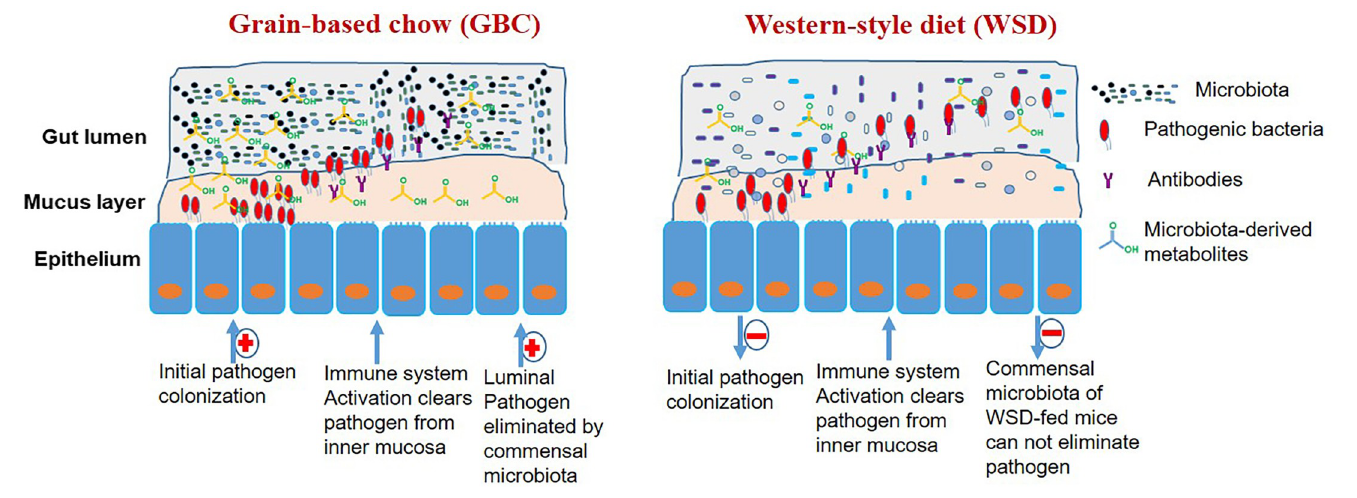
Fig 8. Graphic summary and model. The low-fiber content of WSD impedes initial colonization of pathogens. Immune system functions appropriately irrespective of diet to clear pathogens from the mucosa. Commensal microbiota of mice fed GBC but not WSD is sufficient to eliminate pathogen from the lumen of the intestine. Underlying mechanisms discussed in